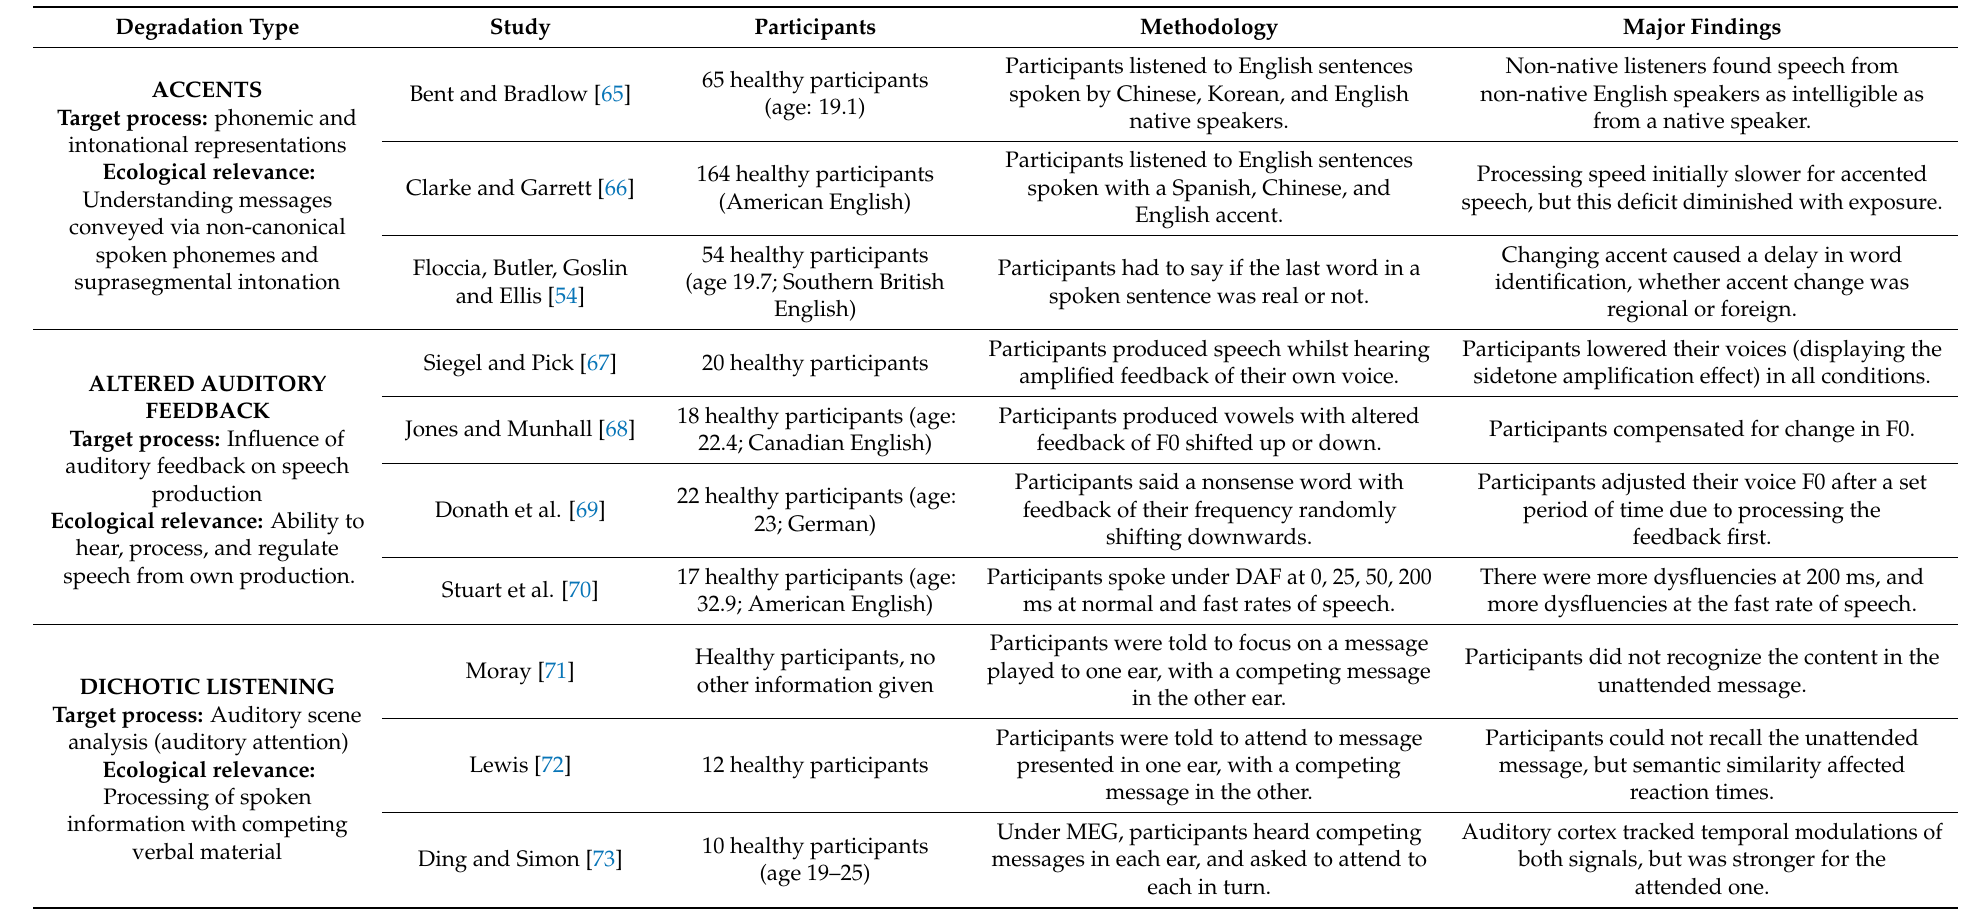
Table 1. Summary of major forms of speech degradation with representative experimental studies in healthy